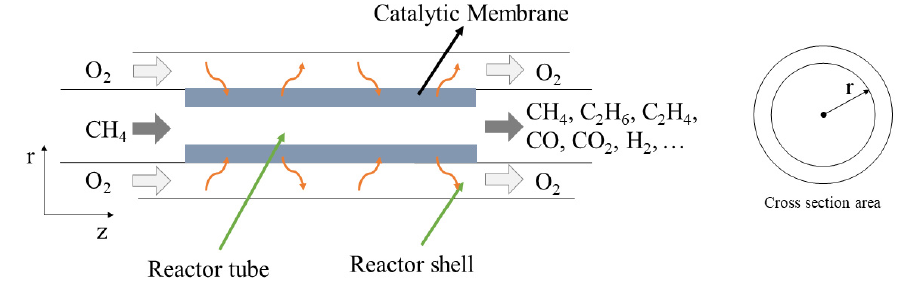
Figure 18. Catalytic membrane reactor configuration [115].